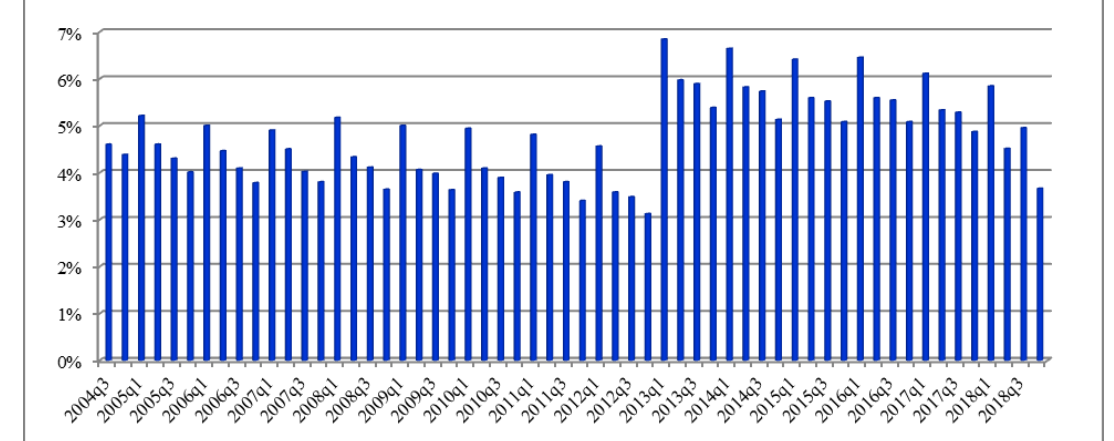
Figure 2. Real estate industry’s contribution to